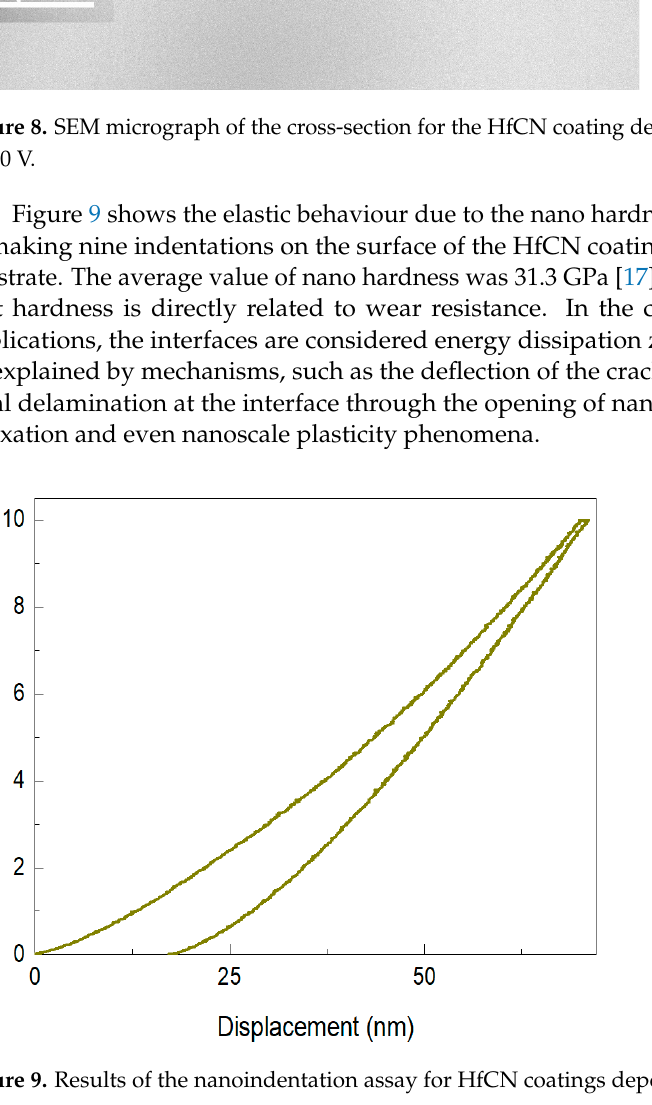
Figure 7. TEM image for HfCN coatings.